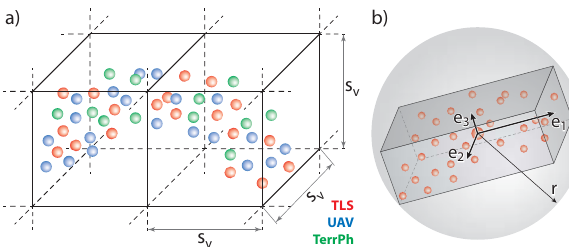
Figure 6. Sketches of the voxel-based integration approach with cubic voxels of size s v (a) and the computation of eigenvectors within a defined spherical neighbourhood of radius r